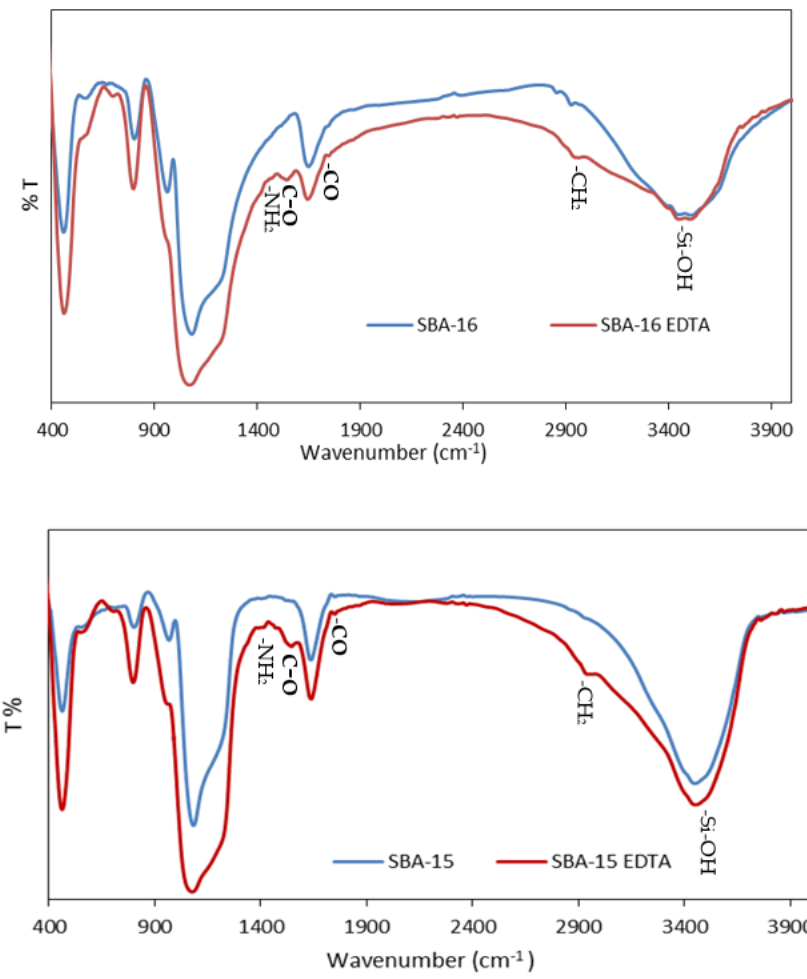
Figure 7. FTIR spectra for SBA-16 and SBA-15 before and after modification.